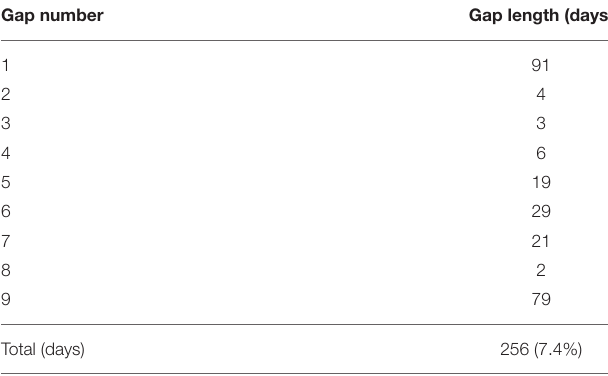
Frontiers in Marine Science |